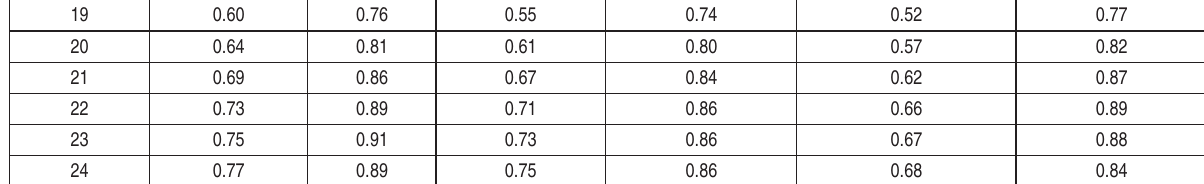
Table 2. Lag analysis of the Ukrainian stock market reactions to the changes of MP instruments (monthly data)